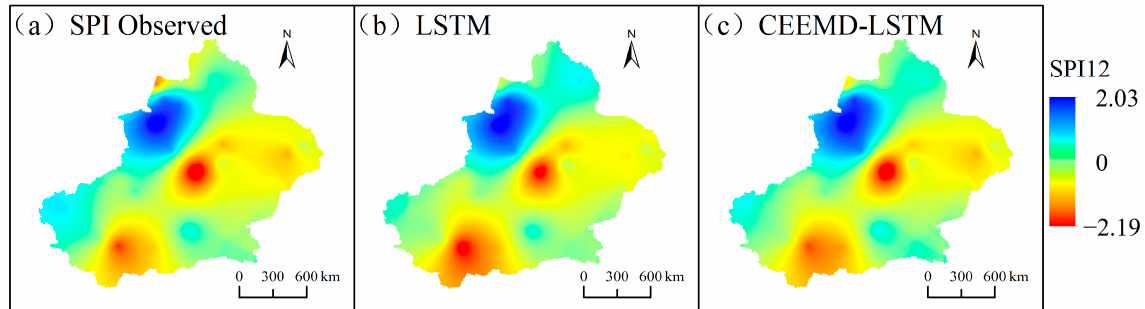
Figure 10. Spatial distributions of SPI in 2011, using LSTM and CEEMD-LSTM model.